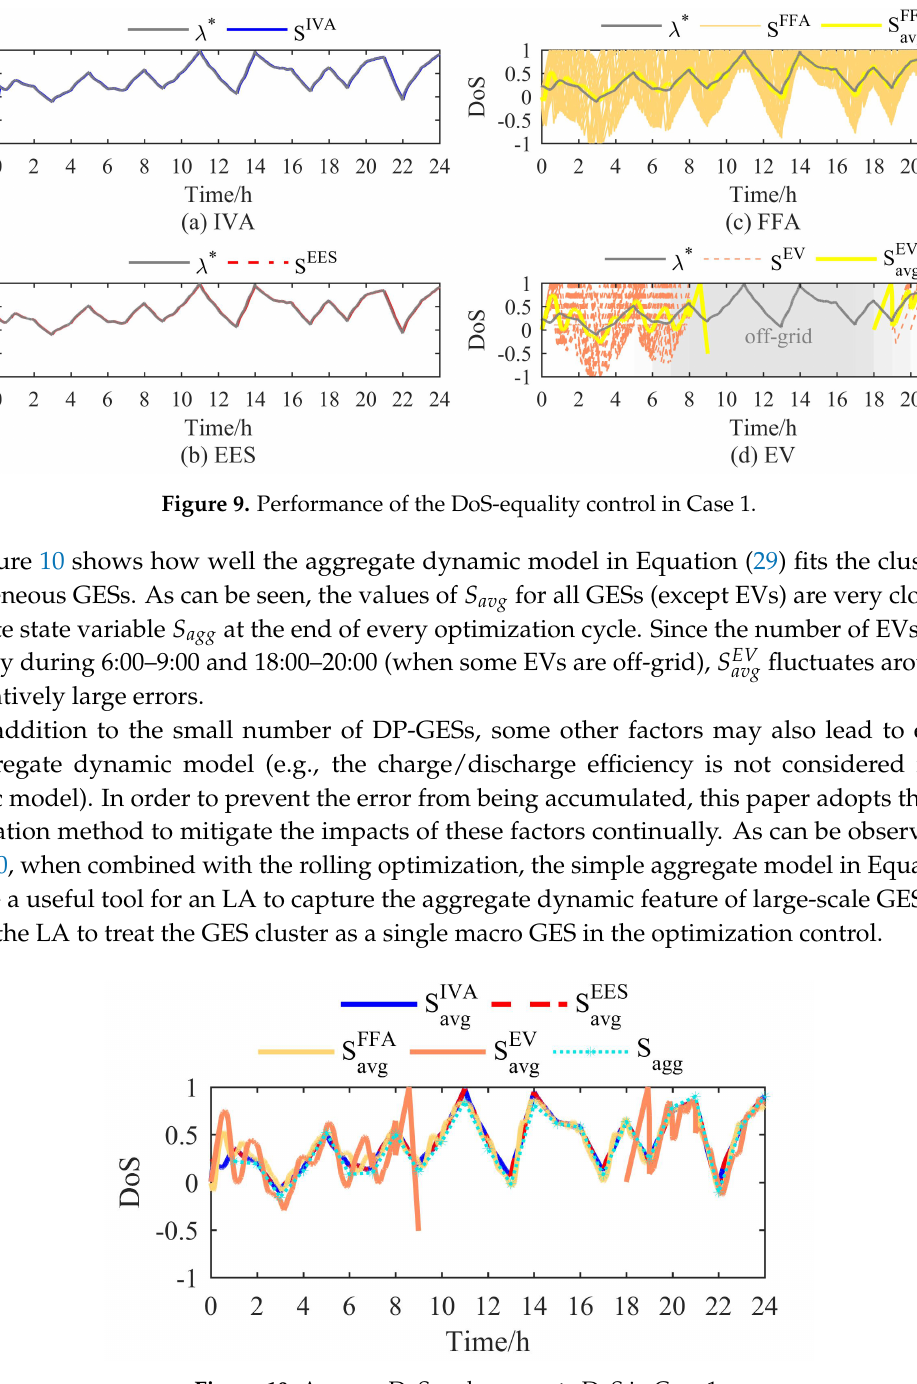
Figure 10. Average DoS and aggregate DoS in Case